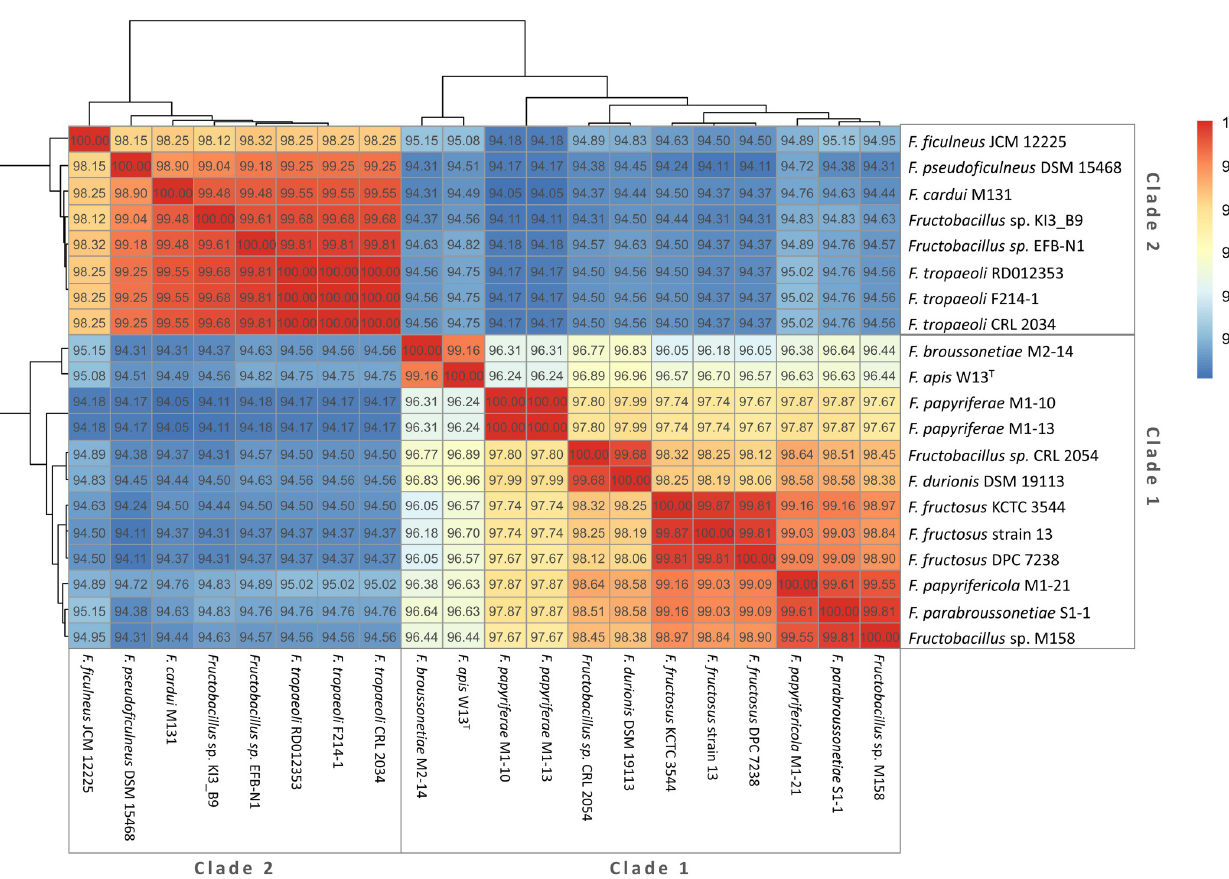
Fig 2. Clustered heatmap showing 16S- rRNA identity between pairs of Fructobacillus strains. Organisms with similar identity values are located in the same cluster.